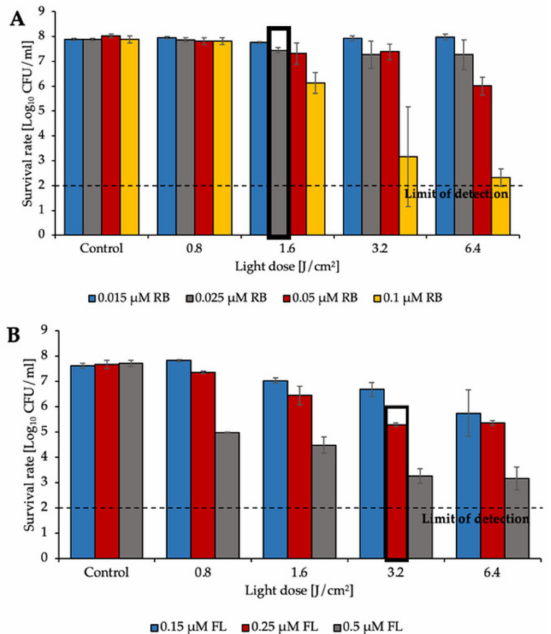
Figure 2. aPDI inactivation of E. faecalis with various doses of green light and ( A ) RB concentrations (0.015, 0.025, 0.05, and 0.1 µ M) or ( B ) FL concentrations (0.15, 0.25, and 0.5 µ M). The experiment was performed in three biological replicates. The detection limit was 100 CFU/mL. Bold frames indicate sublethal